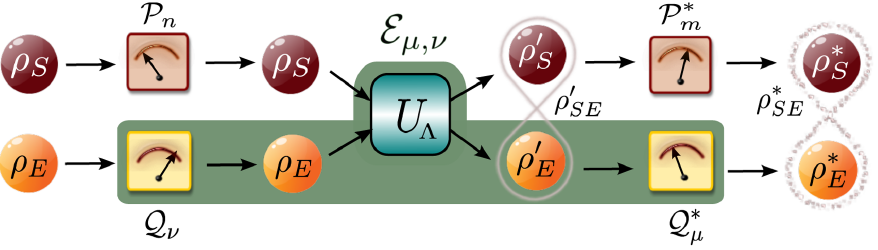
FIG. 1. Schematic picture of the forward process presented in the main text. The system and environment start from an uncorrelated ⊗ ρ ; Q ν g is carried out, which does not alter the density matrix in the state ρ . A local measurement of observables with projectors f P S E n ⊗ j ϕ average evolution but selects a pure state j ψ ν i at the trajectory level. The system and environment then interact with each other n i ; Q (cid:3) μ : g . In according to the unitary evolution U Λ , ending in an entangled state ρ 0 . Finally, we measure again, now using projectors f P (cid:3) m SE the last measurement, quantum correlations in state ρ 0 are erased, while the final state ρ (cid:3) may still have, in general, nonzero classical SE SE correlations. The reduced evolution of the system conditioned to the measurement in the environment is described through the quantum operation E μν (shaded